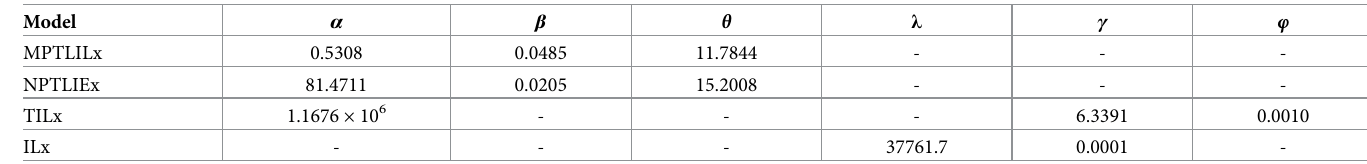
Dataset II: The second data set refers to [26] and is from the industrial sector and represents